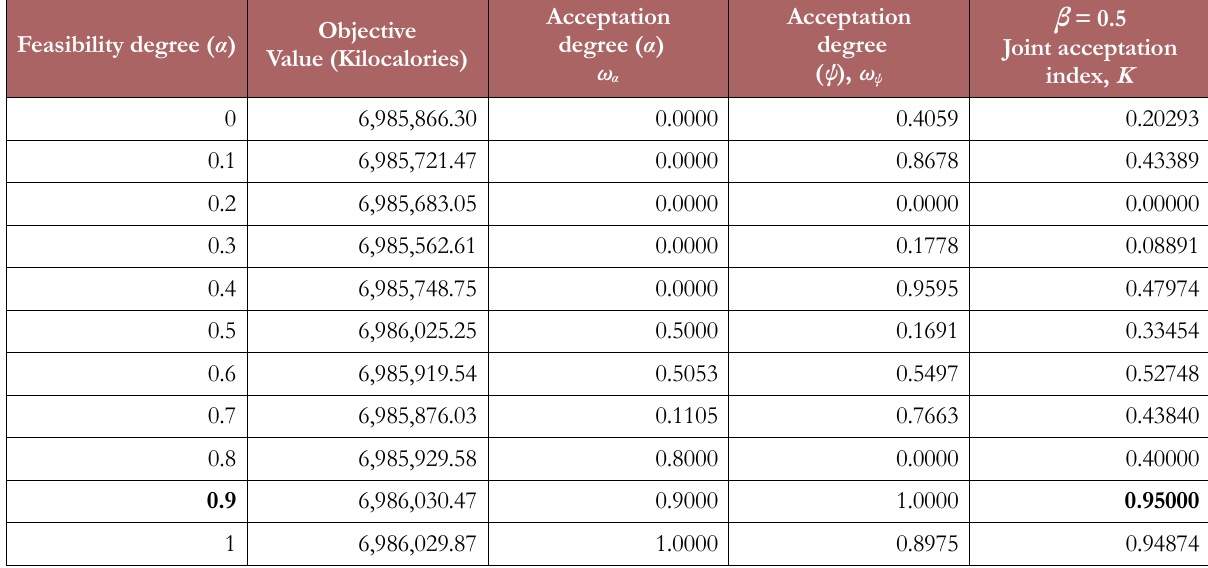
Table 5. Calculation of the joint satisfaction index (K) for each